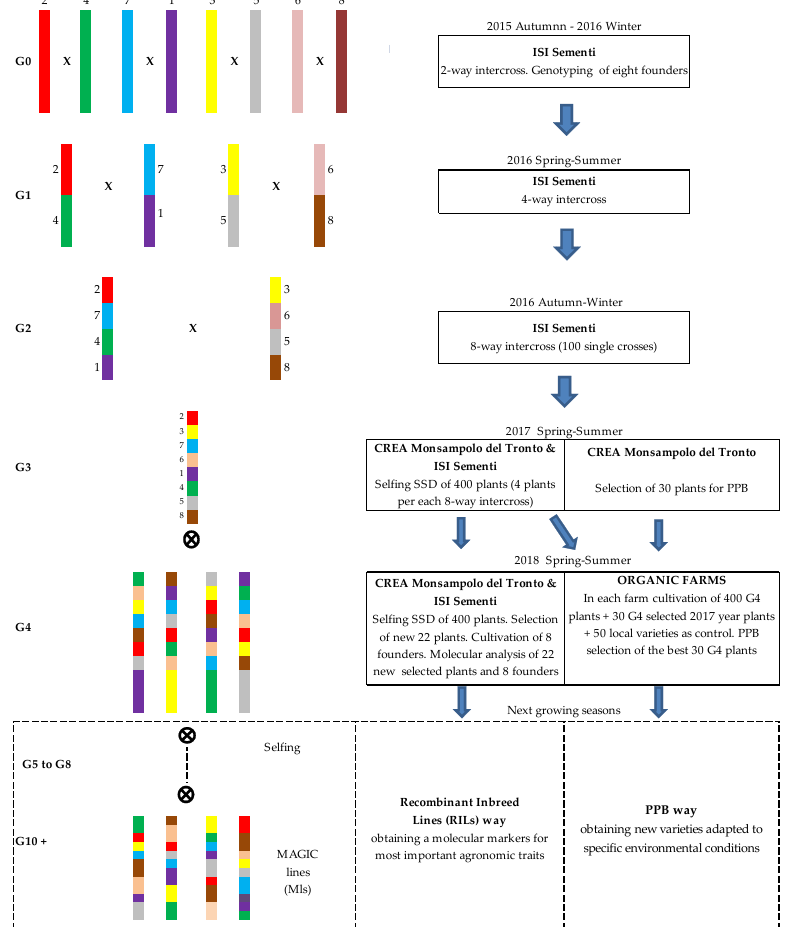
Figure 2. Multi-parent Advanced Generation Intercross population development scheme and the flow chart of the research; plants 1, 2, 3, 4, 6, 7, 8 = ISI lines; 5 = LA1407 ( S. cheesmaniae).